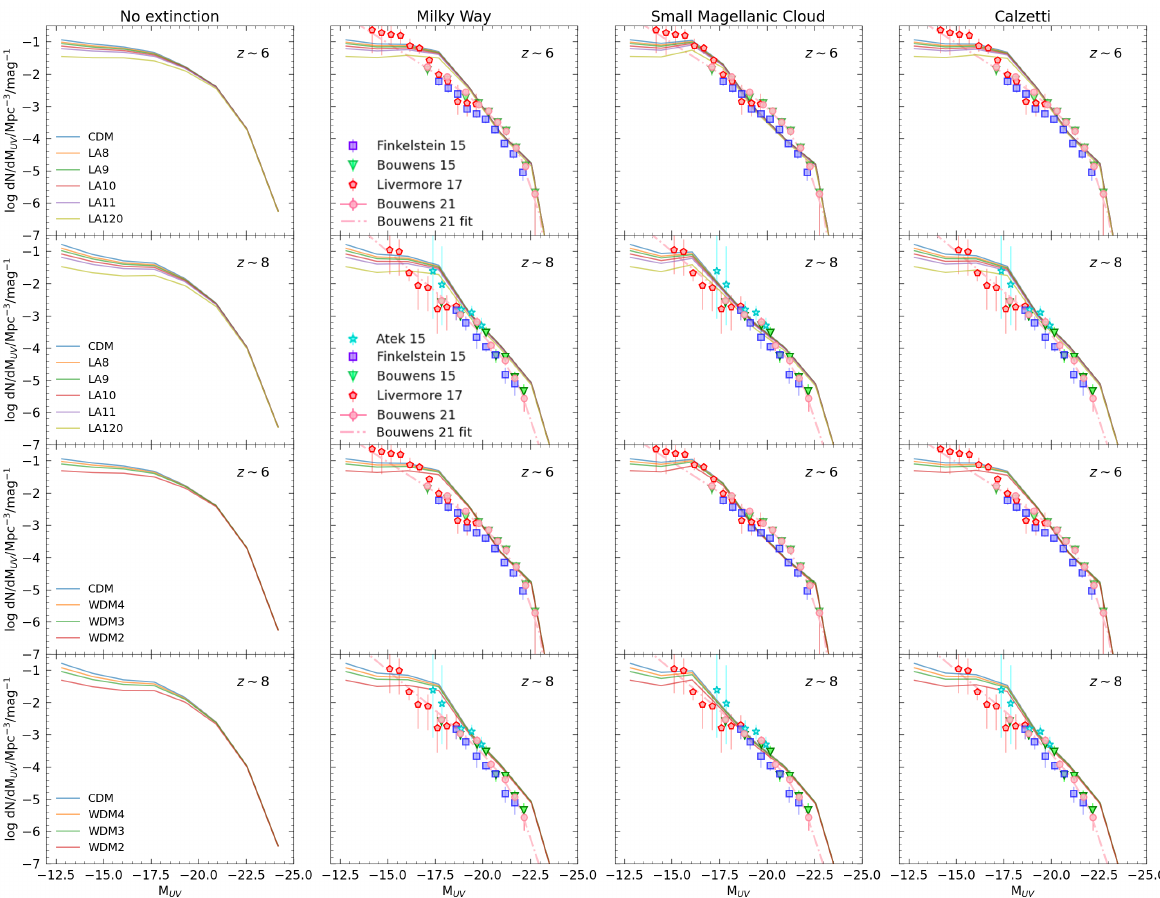
Figure 2. UV LF in different cosmologies, computed using the semi-analytic model with different dust extinction laws and comparison between CDM, 2–3–4 keV thermal WDM and sterile neutrinos. Observational constraints are taken from Atek et al. (2015) [30] (cyan stars), Livermore et al. (2017) [31] (red pentagons), Bouwens et al. (2015) [28] (green triangles), Bouwens et al. (2021) [40] (pink circles) and Finkelstein et al. (2015) [29] (blue squares). The pink dot-dashed line represents the Schechter fit derived in Bouwens et al. (2021)